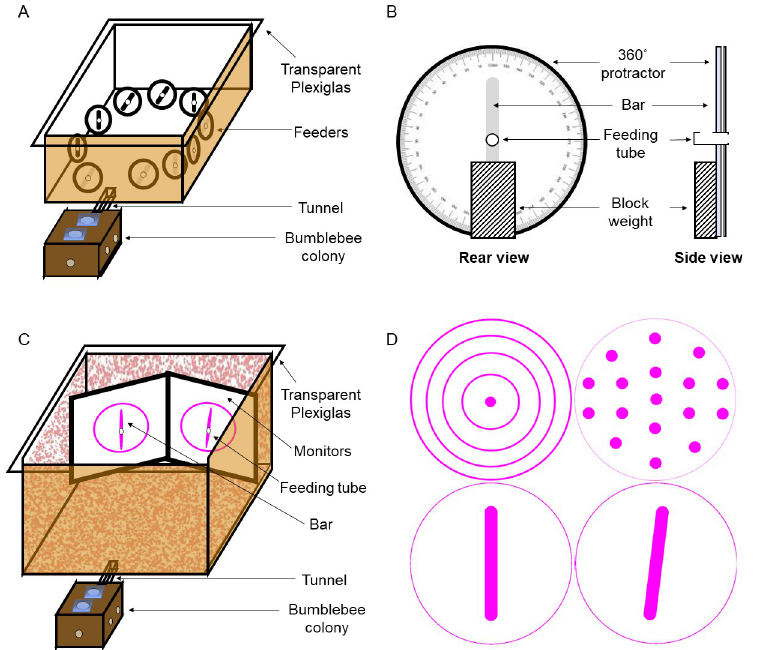
Fig 1. Experimental setup. A: Multiple-choice arena. A bumblebee colony was housed in a wooden box, connected to the experimental arena by a transparent tunnel. Ten feeders were presented in a circle configuration so that all were visible from the centre of the arena. B: Feeder. Each feeder consisted of a white paper disc with a printed black bar, and a feeding tube in the centre. A heavy block weight at the rear of the feeder supported a rotatable 360˚ protractor, allowing the bar to be rotated to the required angle. Five feeders, allocated at random, had the bar oriented to angle A and contained a drop of sucrose solution; the others were oriented to angle B and contained water only. C: Dual-choice arena. Two computer monitors were arranged at a 60˚ angle at the rear of the arena. Each presented a magenta bar in a white circle. A feeding tube was placed at the centre of each bar. One bar, allocated at random was oriented to angle A and the feeding tube contained a drop of sucrose solution; the other was oriented to angle B and contained water. D: Stimuli used in dual-choice experiments. Top row, two stimuli used during pre-training, one on each screen. Bottom row, example bar stimuli used for training and testing: left, 0˚ bar; right, 7˚ bar. All stimuli were displayed in magenta (RGB: 255, 0, 255) on a white background (RGB: 255, 255,